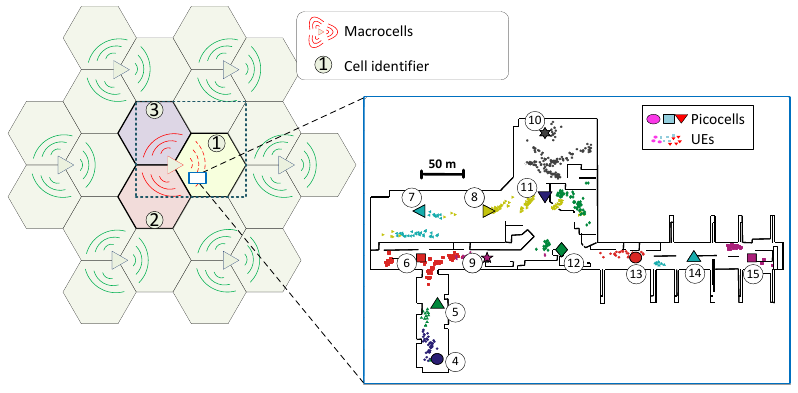
Figure 4. Evaluation scenario.